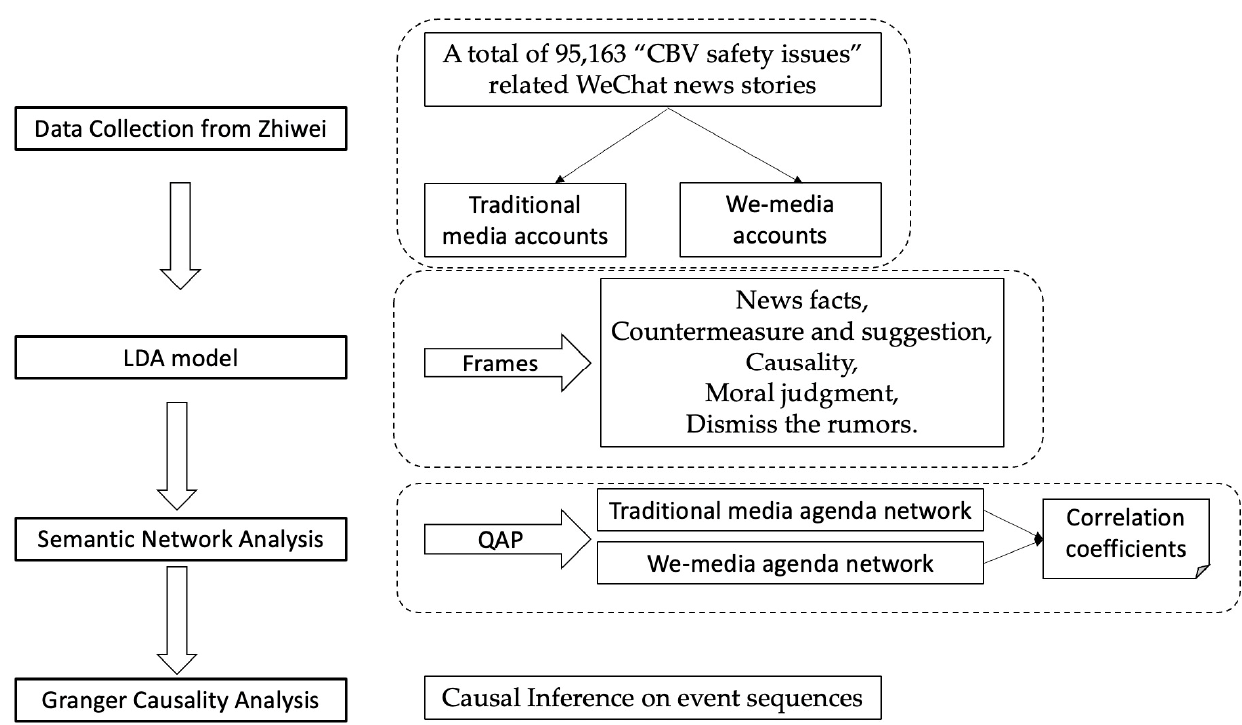
Figure 1. Methodology Flowchart.